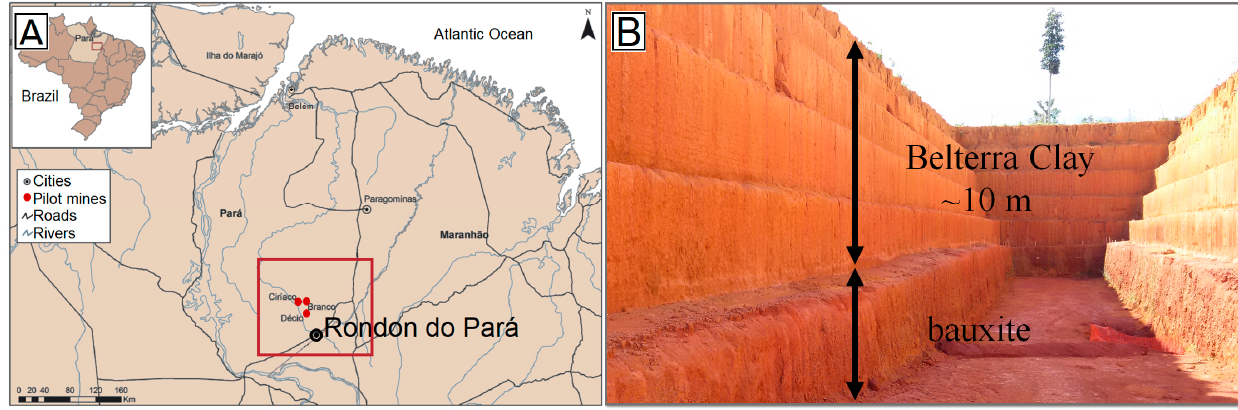
Figure 1. ( A ) Samples location; ( B ) Bauxite mining trench in Rondon do Pará (Brazil) showing the thick Belterra Clay.